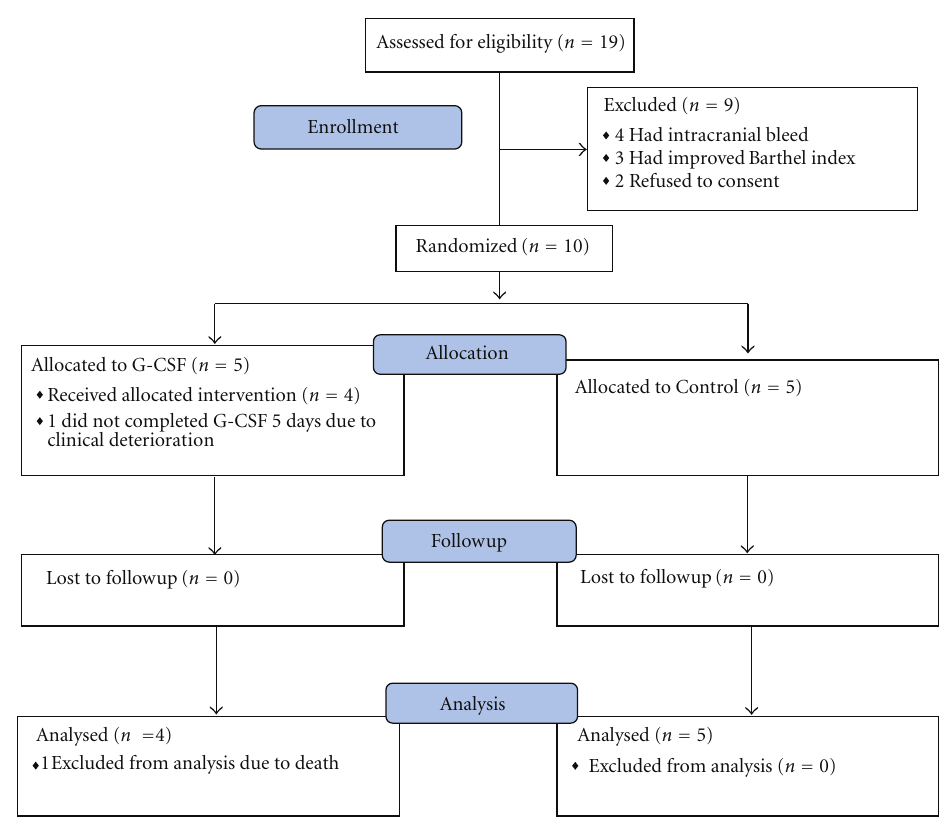
Figure 1: Enrolment, randomization, and analysis of patients.